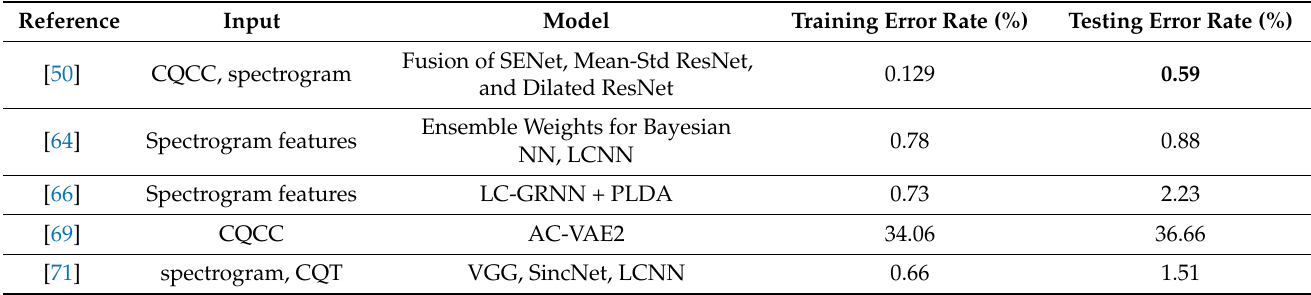
Table 2. State-of-the-art training and testing error rates when using the ASVspoof 2019 replay benchmark